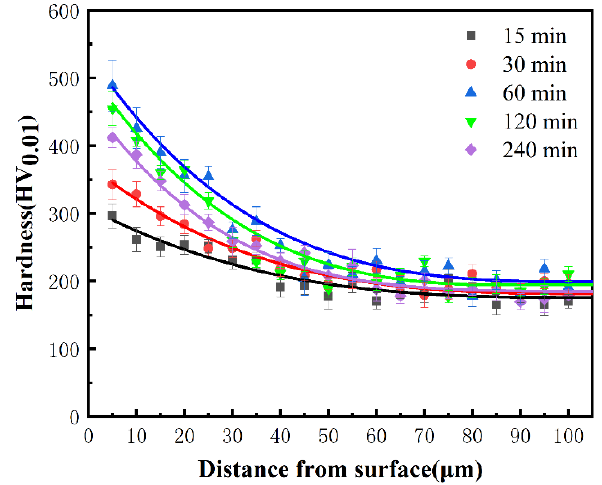
Figure 9. Microhardness changes below the central area of 40Cr pin wear surface after different sliding distances under rotary sliding.